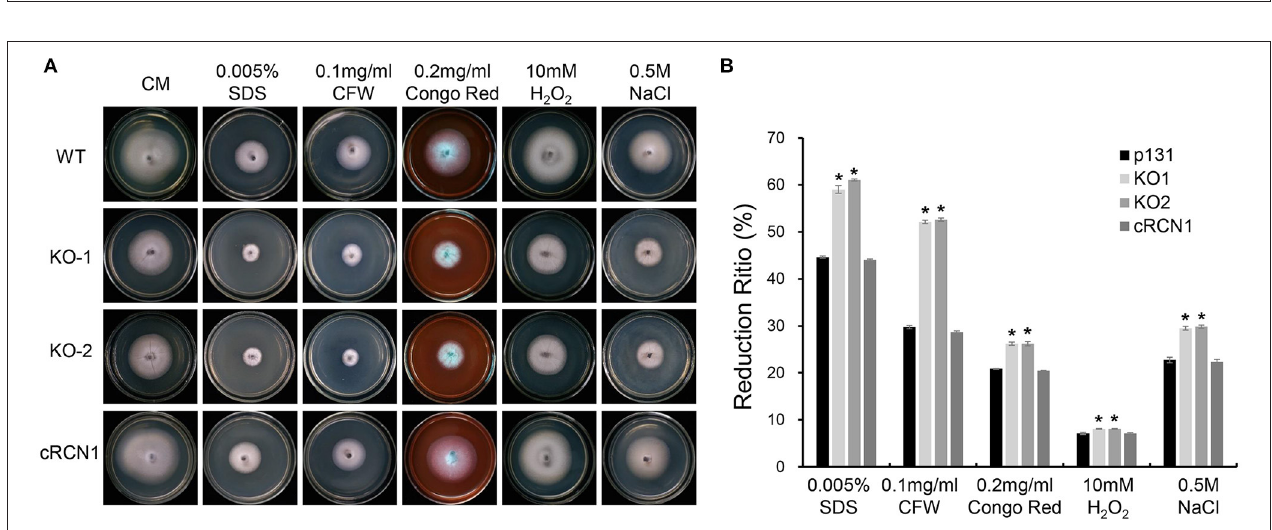
FIGURE 5 | Deletion mutants of MoRCN1 are sensitive to cell wall disturbing agents, oxidative stress, and osmotic stress. (A) Colony morphology of the wild type, 1 Morcn1 mutants, and complemented strain on CM plates supplemented with different cell wall disturbing agents, 10mM H were photographed at 5 dpi. (B) Statistical analysis of growth reduction rates of colony growth under different stress agents. Means and standard errors were calculated from three independent replicates. Significant differences were indicated by asterisks ( P <